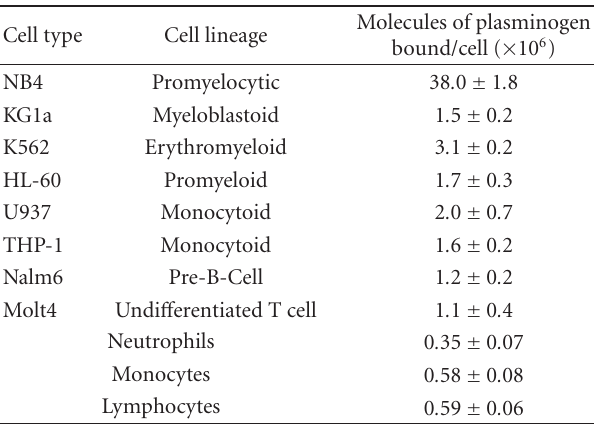
Table 1: Plasminogen binding to cell surfaces of several leukemic cell lines and normal peripheral blood